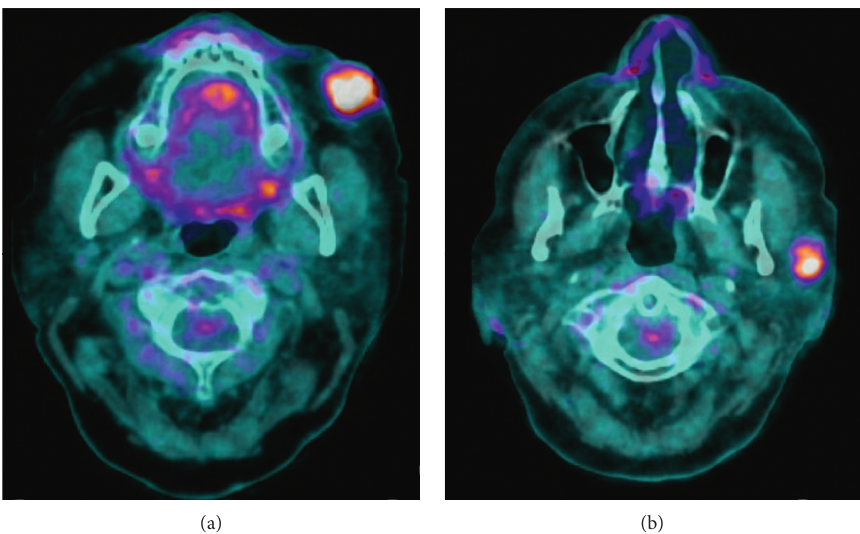
Figure 3: Staging PET/CT scan. (a) Primary site of disease to the left cheek. (b) Regional metastasis to the left parotid.